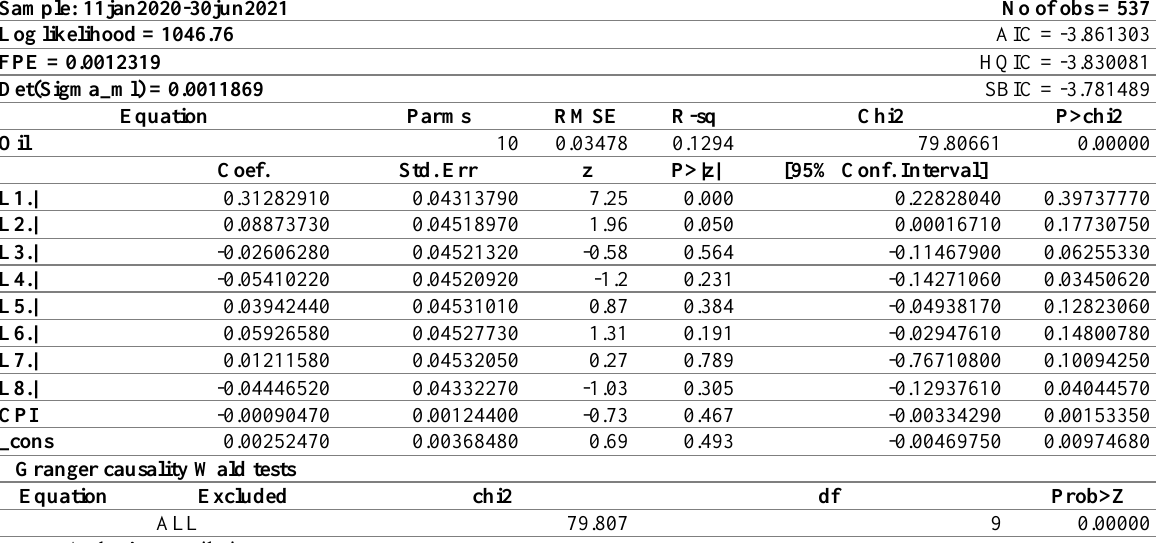
Table 6: VAR and Granger causality wald test results for CPI and crude